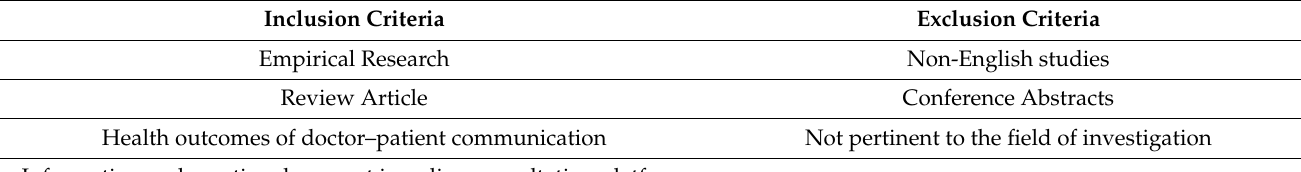
Table 1. Inclusion and exclusion